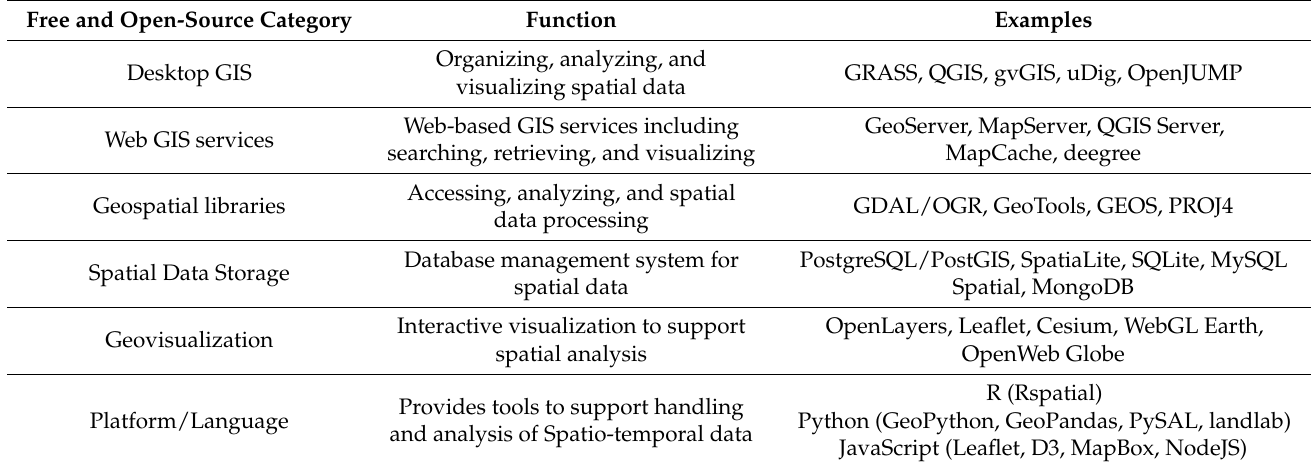
Table 1. Examples of open-source geospatial resources based on various